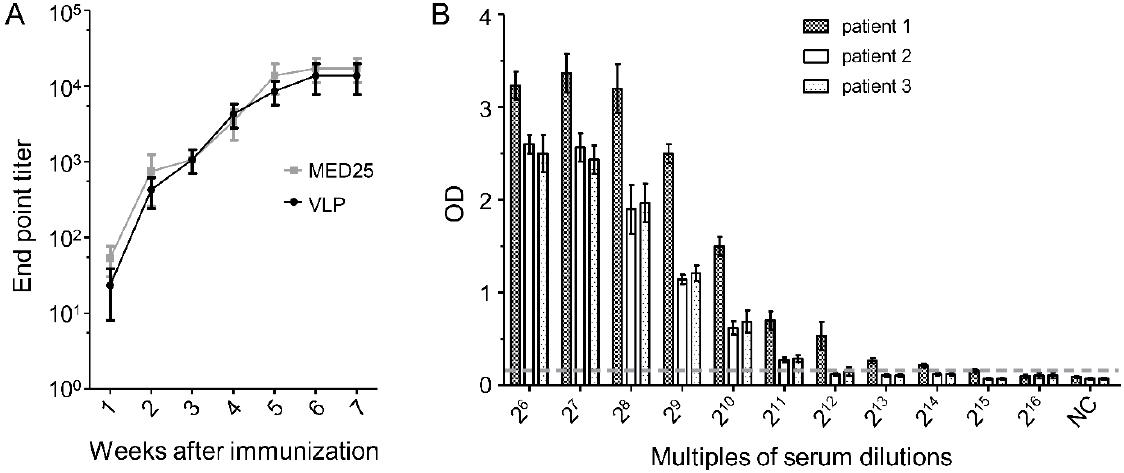
Figure 6. Kinetics of 2H2-like antibodies in immunized animals and prevalence of 2H2-like antibodies in patient serum. ( A ) Rabbits were immunized with MED25 or VLP, and serum samples collected each week were titrated by ELISA using OVA-P as the capture ligand; ( B ) Endpoint titers of 2H2-like antibodies in sera of randomly selected EV71-infected patients were determined by ELISA using OVA-P as the capture ligand. The cut-off value (2.1-fold of negative control value) is indicated by the dotted